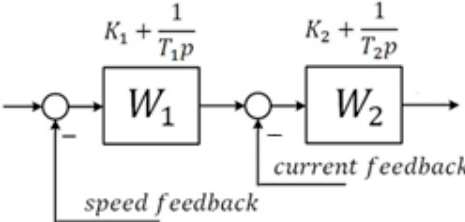
Figure 8. Structure of regulators with slave regulation.